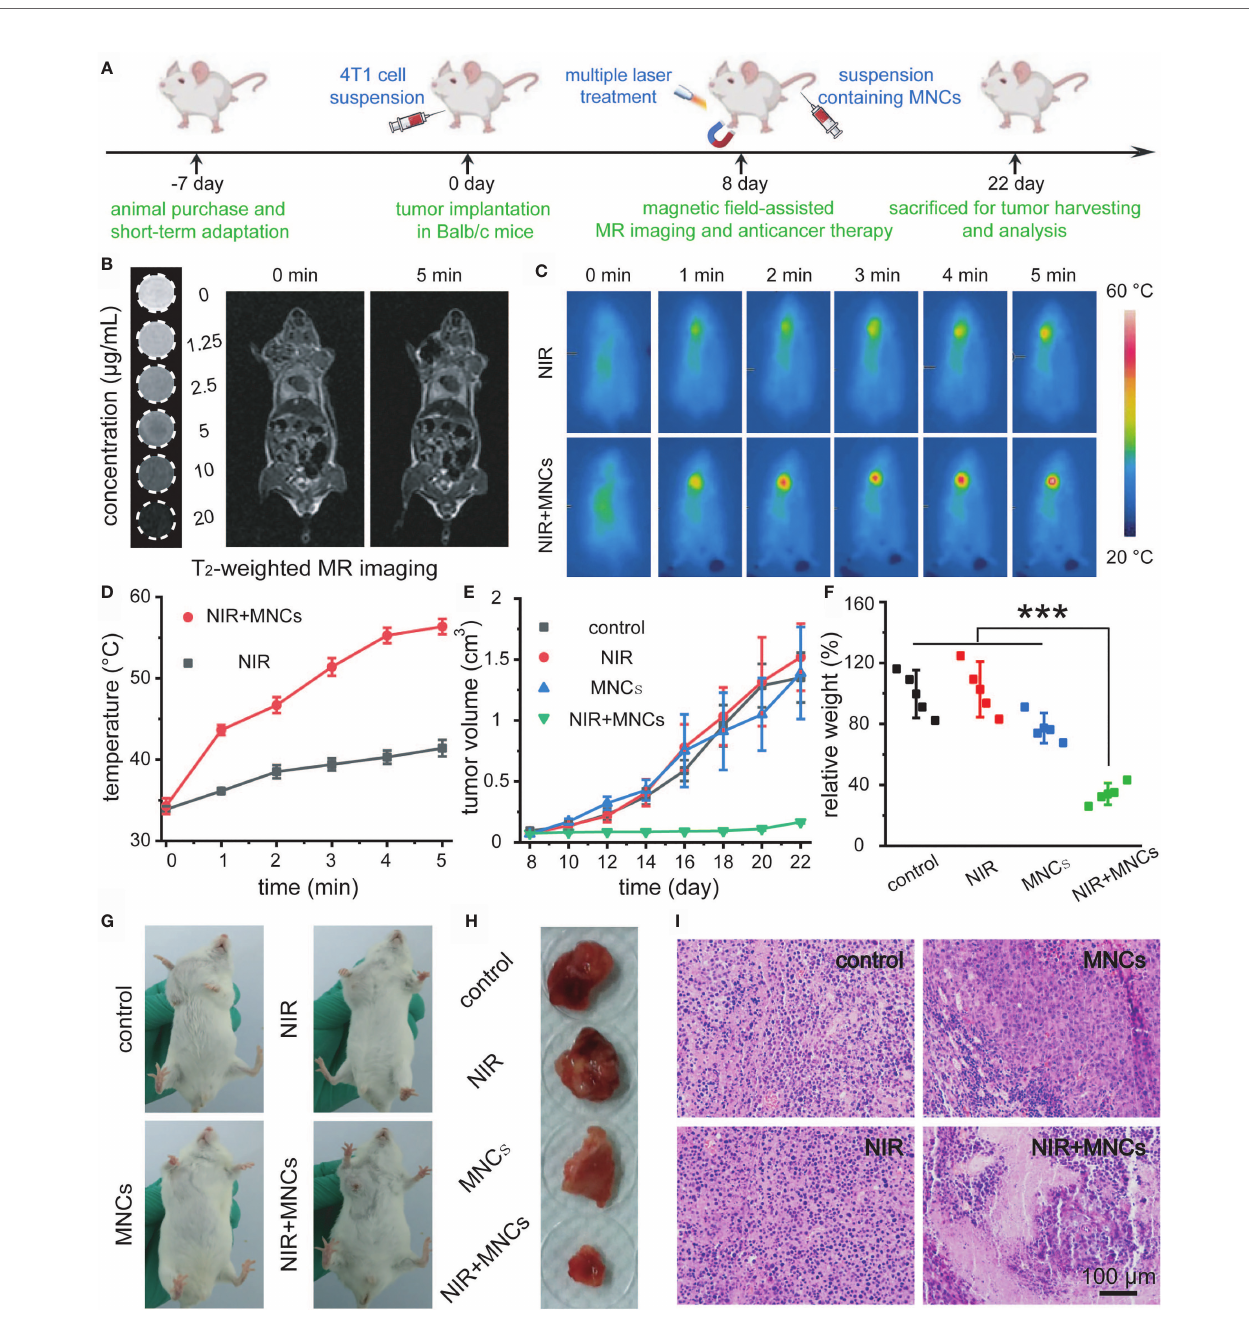
FIGURE 5 | Schematic illustration of the timeline for NIR light-mediated tumor-speci fi c Fenton reaction-assisted oncotherapy (A) . T 2 -weighted MR image of MNCs in aqueous solution and in vivo magnet-assisted MR imaging before and 5 min after intravenous administration of MNCs (B) . Thermal images of tumor-bearing mice (C) and relative temperature pro fi les of tumor sites in mice (D) under different treatments. Tumor growth curves (E) and relative tumor weights at the end of the whole therapy period (F) for the indicated treatments. Photos of tumors in mice (G) and relative tumor tissues collected from mice (H) at the end of the whole therapy period upon different treatments. H&E staining of tumor tissues after various treatments (I) . Asterisks indicated statistical signi fi cances (* p < 0.05, ** p < 0.01, *** p <